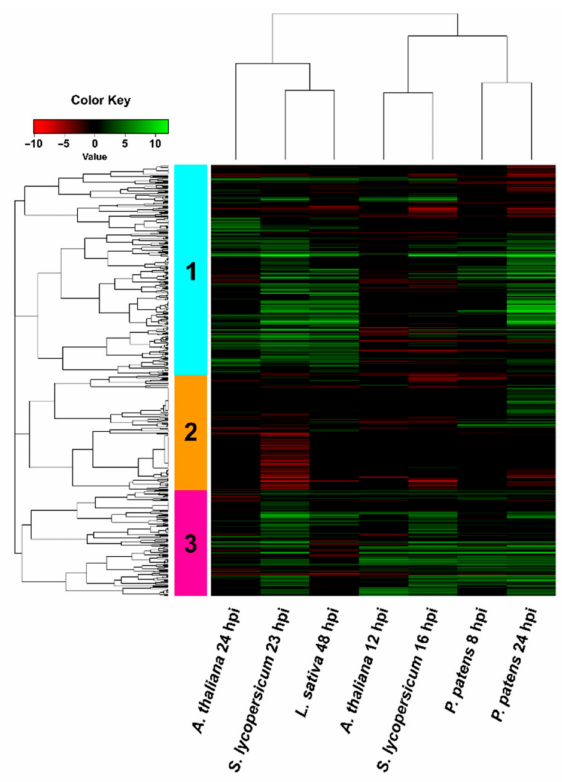
Figure 6. Hierarchical clustering (heat map) showing genes encoding secreted B. cinerea proteins during infection of P. patens and different angiosperms. Only DEGs that passed FDR ≤ 0.05 were considered in the analysis. For samples where no significant difference with control was observed (FDR > 0.05) or no data was available, the log2 FC was assigned as cero. See Table S12 for complete